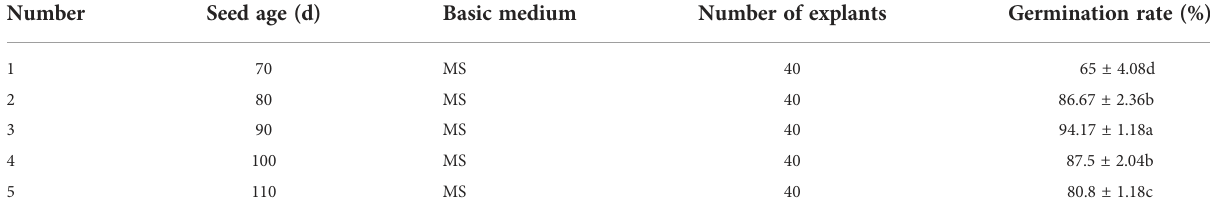
Different lowercase letters represent signi fi cant difference at 0.05 level (Duncan, P = 0.05).